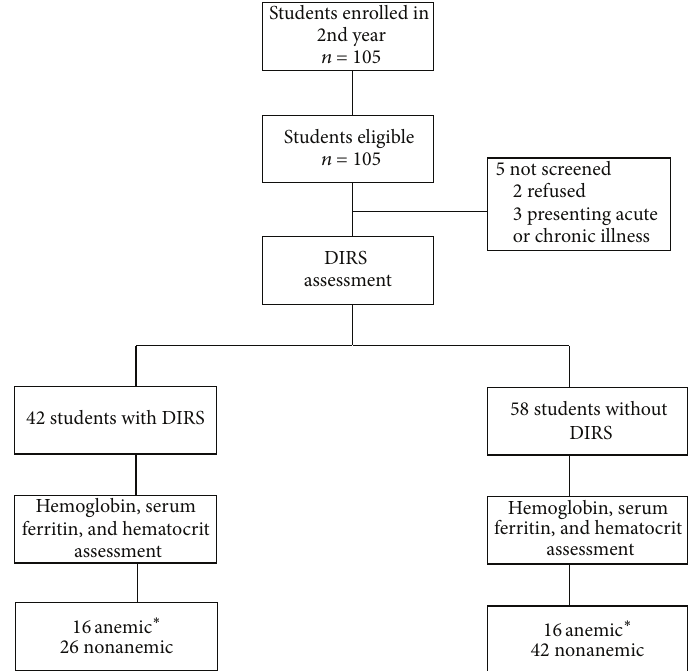
Figure 1: Study profile. ∗ Hemoglobin concentration <